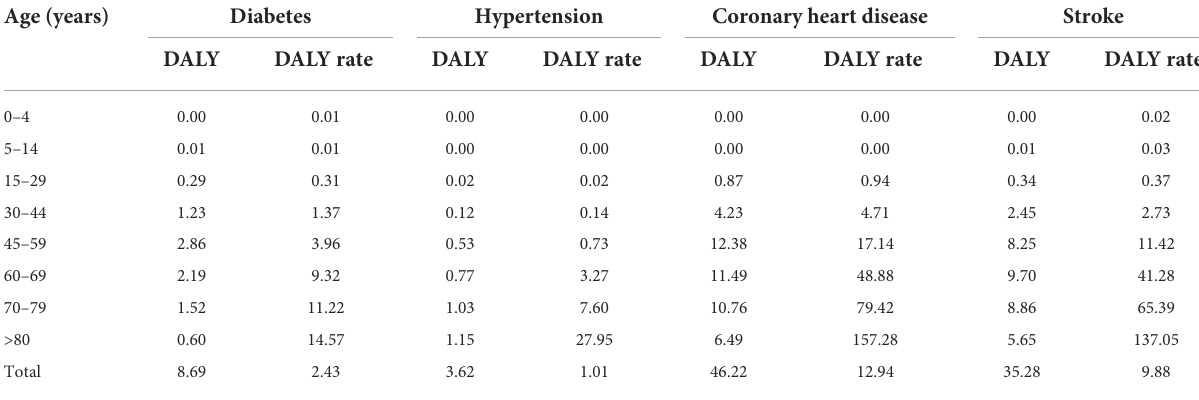
TABLE 2 Distribution of DALY in different age groups for major chronic diseases. Age (years) Diabetes Hypertension Coronary heart disease